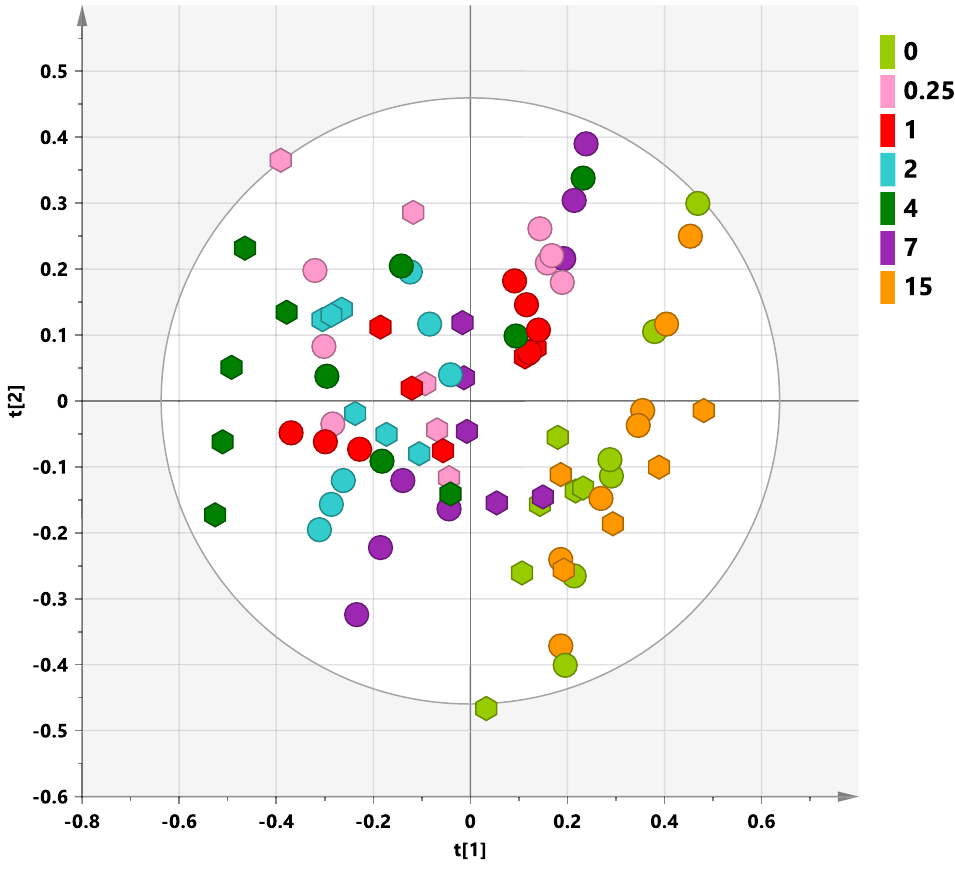
Figure 2. PCA t[1][2] scores plot (five components give R2X = 0.832, Q2 = 0.757) for leaf samples from Ogliarola salentina (circles) and Cima di Melfi (hexagons) cultivars tree at day 0 (before injection) and 0.25, 1, 2, 4, 7 and 15 days after injection. Sample symbols are colored according to different days of the treatment.